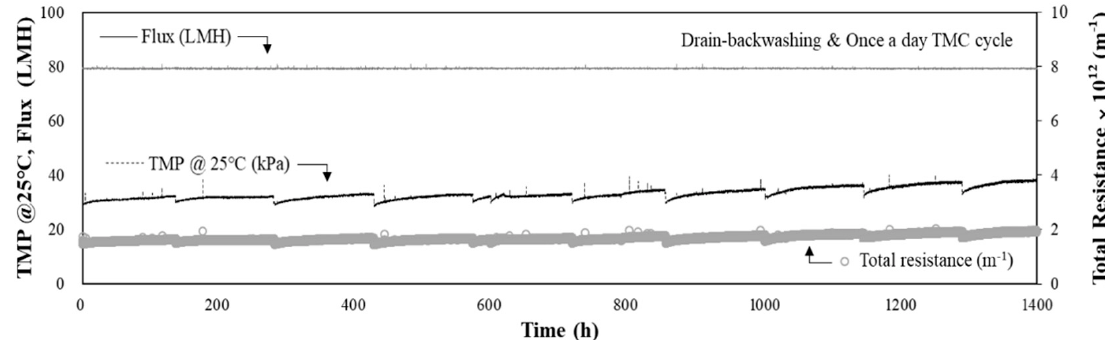
Figure 8. TMP and total resistance during the operation of DAF-MF combined process with high-turbidity raw water (max. turbidity = 83.0 NTU, coagulant dose =40 mg/L, hydraulic loading rate = 10 m/h, flux =80 LMH) .